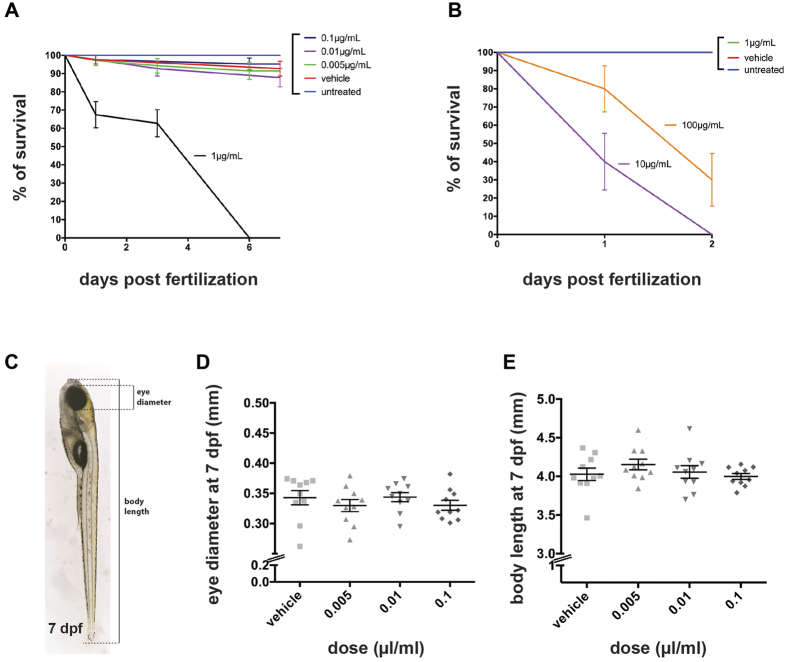
Pyriproxyfen is toxic at high doses.(A) Percentage of survival of embryos treated from 2–4 cell stage with various pyriproxyfen concentrations ranging from 0,005 μg/ml to 1 μg/ml. The latest dose appears to be lethal with 100% of death after 5 days of development. Lower doses of pyriproxyfen (0,005; 0,01; 0,1 μg/ml) do not induce a severe decrease in the survival rate (N = 2 batches, n = 20 embryos per condition). (B) Higher doses of pyriproxyfen (10 and 100 μg/ml) are lethal as early as 2 dpf (N = 2, n = 20). (C) Representation of measurements performed on 7 dpf larvae to assess gross morphology effects. (D,E) Eye diameter and body length at 7 dpf of pyriproxyfen-treated embryos are not significantly different from vehicle (EtOH)- treated embryos (p > 0.05) (n = 10 per condition).